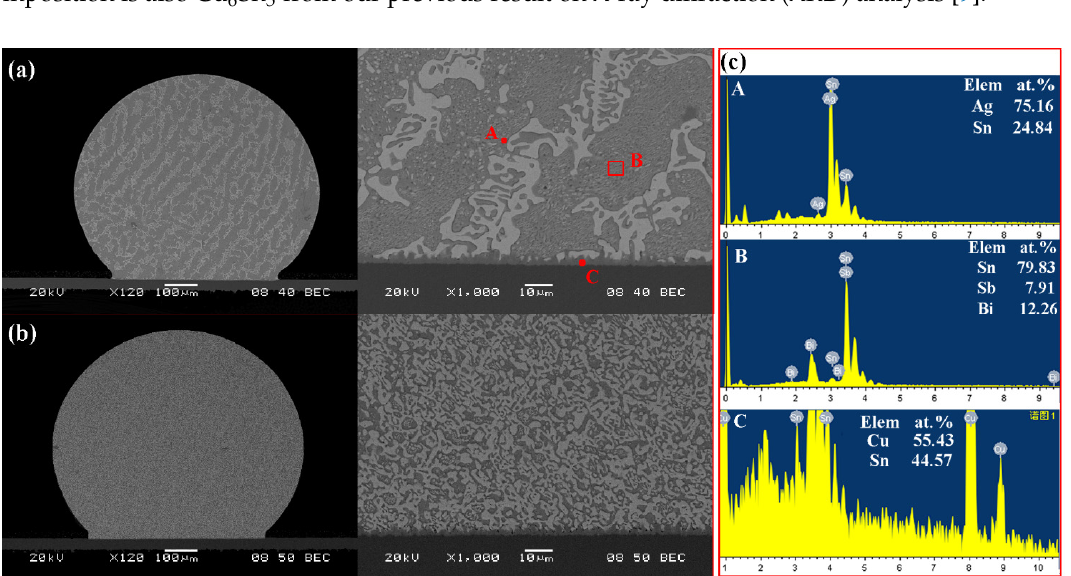
Figure 3. Microstructural observation and compositional analysis in soldered joints for ( a ) Sn ‐ 38Bi ‐ 1.5Sb ‐ 0.7Ag solder, ( b ) Sn ‐ 58Bi solder and ( c ) energy dispersive spectrometer (EDS) results on marked phases in Sn ‐ 38Bi ‐ 1.5Sb ‐ 0.7Ag solder joint.